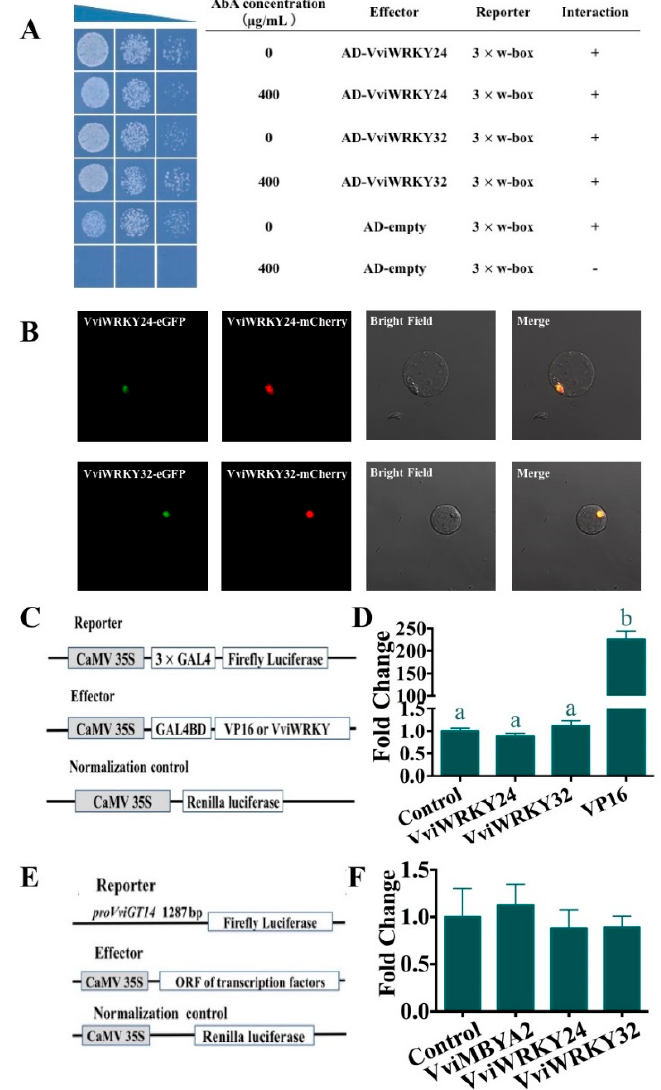
Figure 3. Identification of potential regulation of VviWRKY24 and VviWRKY32 on VviGT14. A . Yeast-one-hybrid assay showing that yeasts carrying a combination of effector and reporter vectors can grow on the medium without or with 400 ng/mL antibiotic aureobasidin A (AbA), whereas yeasts with AD and 3× w-box cannot grow on the media with 400 ng/mL AbA. The present result indicates that both VviWRK24 and VviWRKY32 can bind with the 3 repeat w-box sequence. B . Subcellular localization of VviWRK24 and VviWRKY32 in Arabidopsis protoplast. The graphs from left to right represent VviWRKY-eGFP, nucleus marker-mcherry, bright field, and the merge images. The present result indicates that both of the two TFs are specifically located in the cell nucleus. C. The reporter, effector and normalized control constructs used in the transcriptional activity assay. D. Transcriptional activation domain analysis of VviWRKY24 and VviWRKY32; The transcriptional activation functions of VviWRKY24 and VviWRKY32 were tested using the luciferase assay. The control represents empty pBD vector and its fold change is set as 1. VP16, an unusually potent transcriptional activator, is regarded as a positive control, and its activity change exceeds 200-fold. The error bars represent S.E.s from six biological replicates. Significant differences relative to the control are determined using the one-way ANOVA tests (**, P < 0.01). The present result indicates that both of the two TFs lack the transcriptional activation domain. E. The reporter, effector and normalized control constructs used in the dual luciferase assay. F. The transcriptional regulation assessment of VviWRKY24 and VviWRKY32 on the VviGT14 promoter activity in a transient expression system in Vitis vinifera L. “Chardonnay” cell suspension using dual luciferase assay. VviMYBA2 (BAD18978), a specific transcription factor in anthocyanin biosynthesis, is taken as negative control to test the reliability of this reaction system. The present result indicates that both of the two TFs have no transcriptional regulation effects on VviGT14 promoter. The data were shown as the mean ± SD from at least six biological replicates. ANOVA tests (*, P < 0.05. **, P < 0.01).